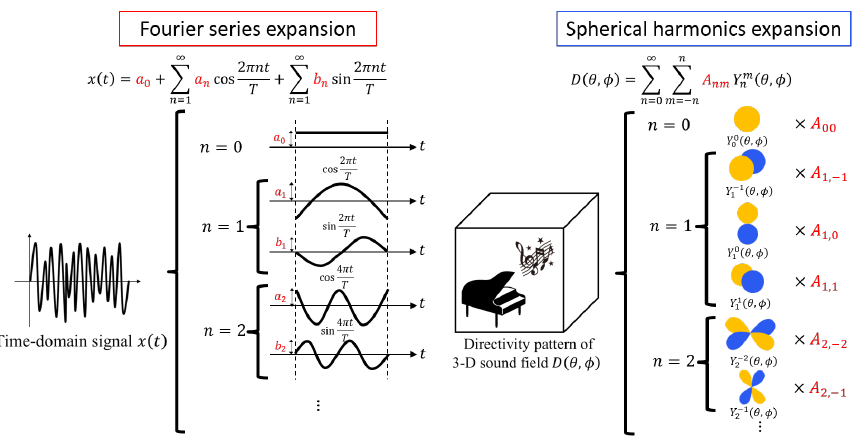
Figure 4. Examples of Fourier series expansion and spherical harmonic expansion (SH) expansion.